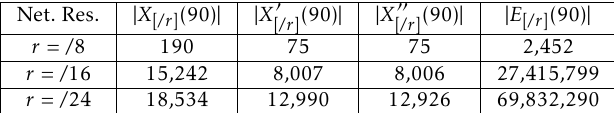
Table 3. Stationarity and G-causality test results of the time series with at least 30 non-zero observations up to time T | is the number of time series at a network where | X [ r ] (90) resolution r ∈ { / 8 , / 16 , / 24 } that are tested, and | X (cid:48) the number of time series that are stationary, | X (cid:48)(cid:48) number of time series that have at least one G-causality arc, and | E | is the total number of G-causality [ r ] (90)